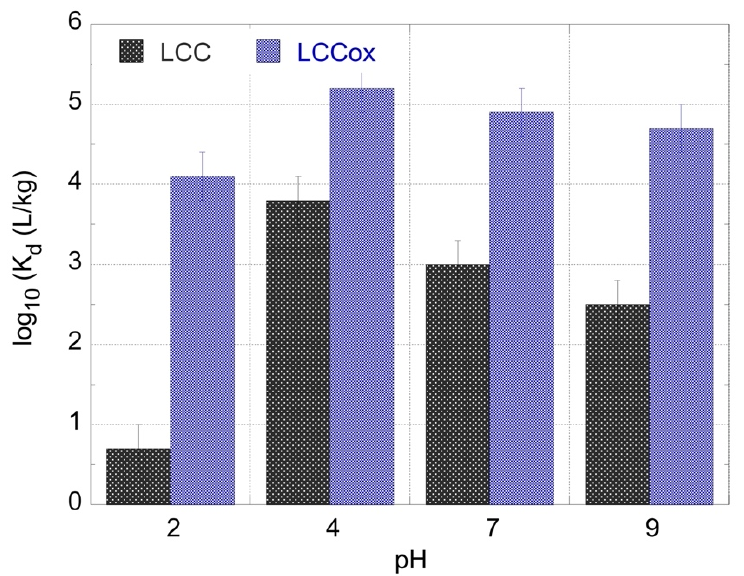
Figure 2. The K d values for the U(VI) adsorption by two different types of biochar fibers as a function of pH. [U ‐ 232] = 8.6 × 10 − 14 mol/L, biochar mass = 0.01 g and ambient